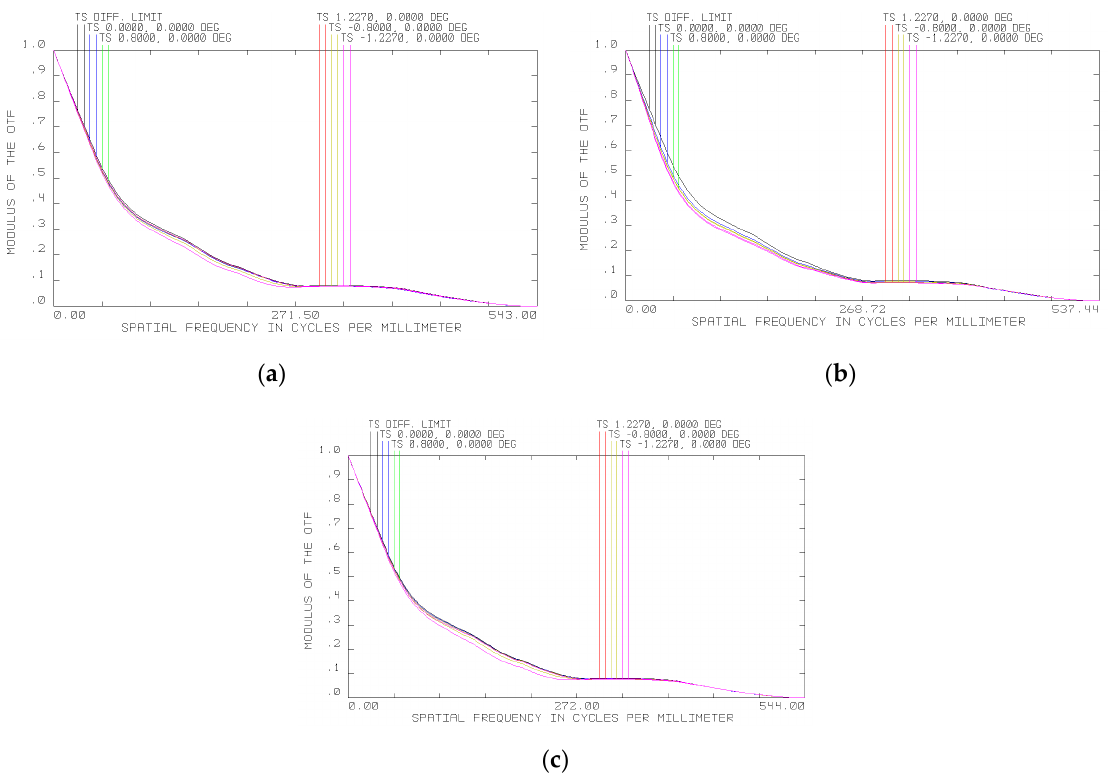
Figure 5. Modulation transfer function (MTF) of the objective at ( a ) 20 °C, ( b ) − 40 °C, and ( c ) 45 °C.